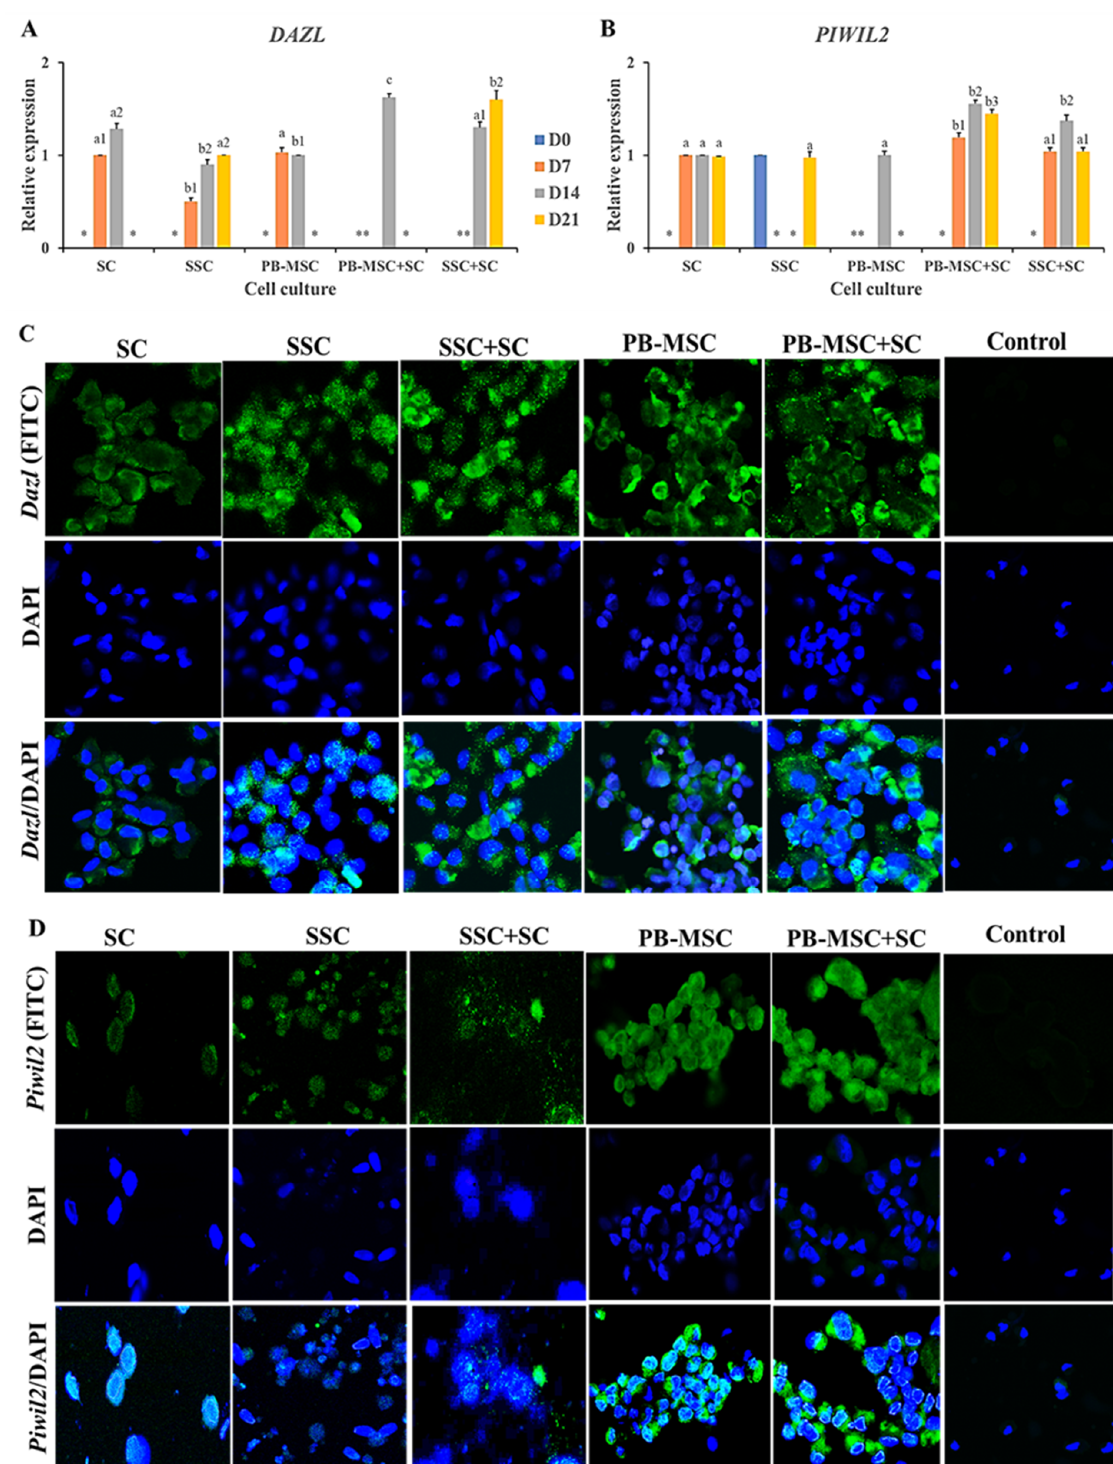
Figure 4. Expression of GC markers DAZL and PIWIL2 in single cultures and co-cultures of bull PB-MSC, SSC with SC in 3D SACS for 21 days. ( A ) MSC+SC co-culture up-regulated ( p < 0.05) DAZL gene expression on day 14, while SSC+SC co-culture up-regulated ( p < 0.05) DAZL gene expression on day 21. ( B ) PIWIL2 relative expression was higher ( p < 0.05) in MSC+SC and SSC+SC co-cultures at day 14. At day 21 the relative expression of PIWIL2 was higher ( p < 0.05) in MSC+SC co-culture. ( C ) Intense immunofluorescence associated to DAZL was observed in SSC and PB-MSC single cul- tures and SSC+SC and MSC+SC co-cultures at day 14. ( D ) PIWIL2 was immunodetected in PB-